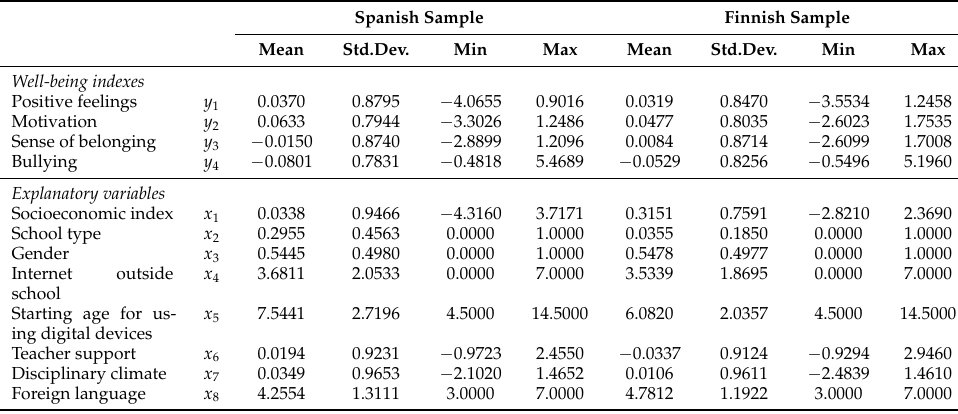
Table 2. Descriptive statistics of the